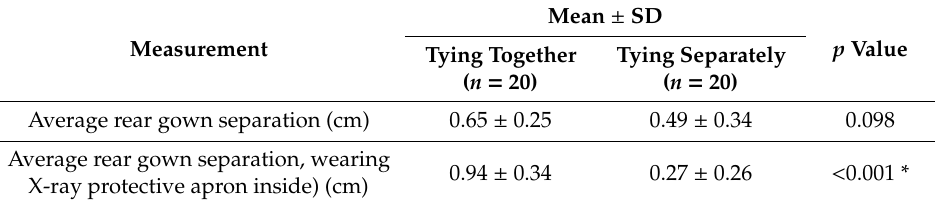
Table 1. Comparison of tie loosening by measurement of the rear gown cloth separation after